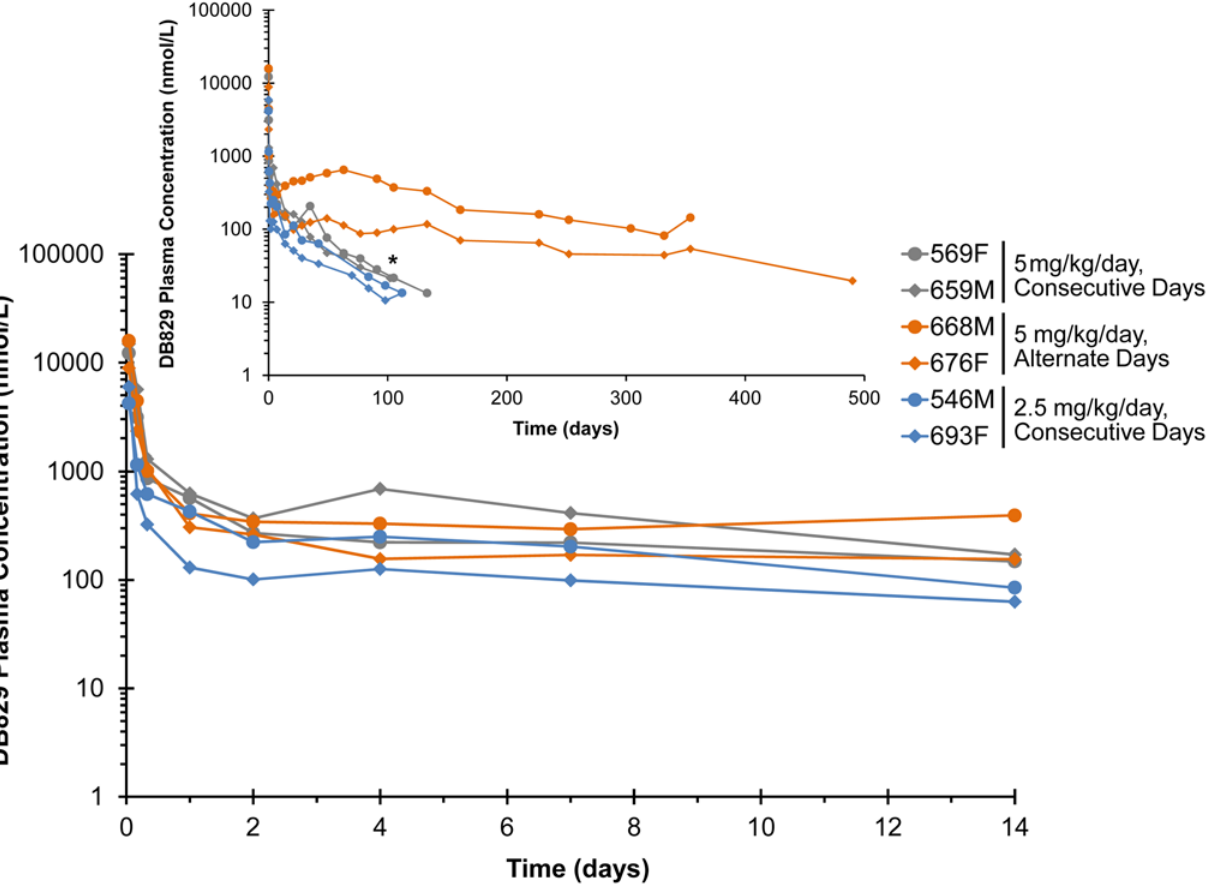
Fig 8. Plasma concentration-time profiles following administration of the active diamidine DB829 to infected vervet monkeys. Monkeys confirmed to have second stage HAT were administered DB829 intramuscularly, beginning at 28 days post-infection with T. b. rhodesiense KETRI 2537, at 5 mg/kg/day for 5 consecutive days, 5 mg/kg/day for 5 alternate days or 2.5 mg/kg/day for 5 consecutive days. The inset graph shows the extended profile out to the end of the study. * denotes the time (91 days post-last drug dose) that monkey 659 was euthanized due to non-drug related complications (pneumonia). F, female; M, male.